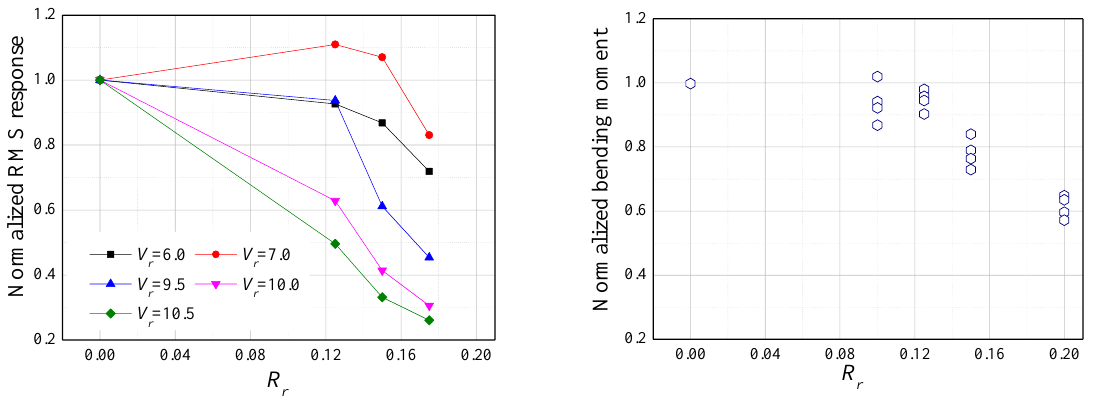
Figure 14. Comparison between the result of this paper and that of Zhang ’s [19].